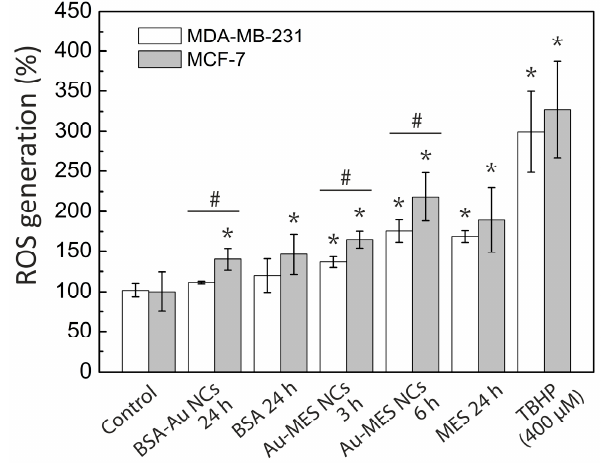
Figure 9. Reactive oxygen species (ROS) generation in MCF-7 and MDA-MB-231 cancer cells after treatment with BSA-Au NCs, Au-MES NCs, BSA, and MES. The data normalized according to the non-treated cells (Control), tert -Butyl hydroperoxide (TBHP) treated cells were taken as a positive control. Error bars show the standard deviations. * indicates significant differences compared to the non-treated cells ( p ≤ 0.05); # indicates significant differences between the MCF-7 and MDA-MB-231 cell lines ( p ≤ 0.05).